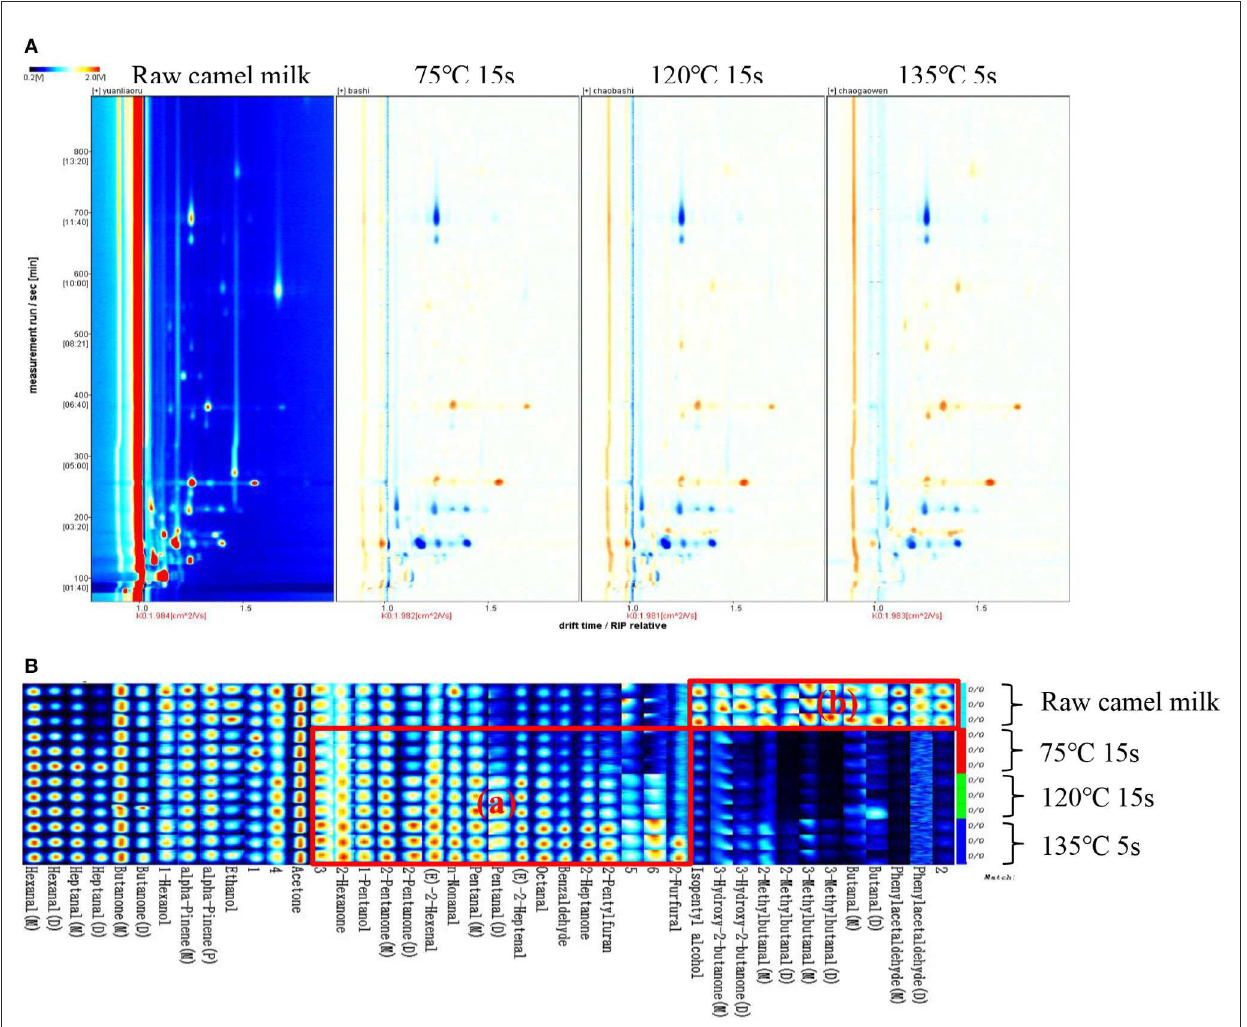
FIGURE4 GC-IMS spectra (A) and gallery plot (B) of volatile organic compounds in camel milk of 4 different heat